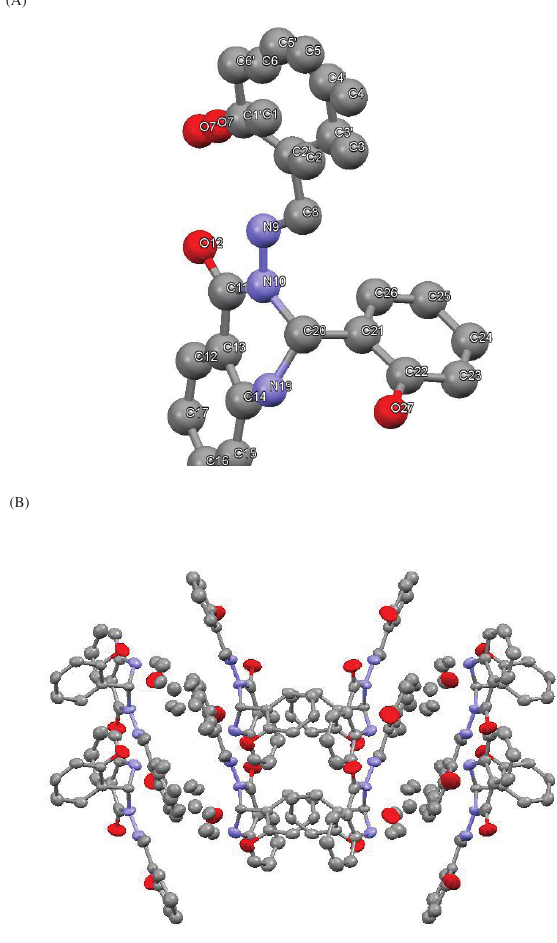
Figure 2: (A) Molecular structure of H-HHAQ. Thermal ellipsoids are